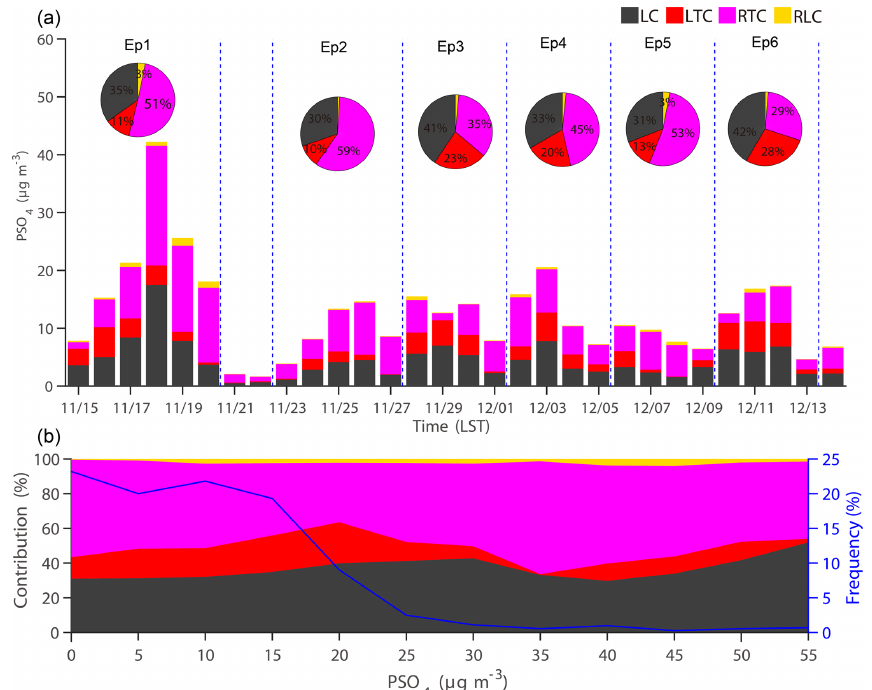
Figure 9. (a) Sources of secondary sulfate in Beijing. (b) Variation of secondary sulfate sources with the surface sulfate concentration in Beijing for the whole study period. LC refers to sulfate locally produced from SO 2 emitted in Beijing; LTC refers to sulfate chemically formed in regions outside of Beijing from SO 2 emitted in Beijing; RTC is sulfate chemically formed along the transport pathway to Beijing from SO 2 emitted in source regions outside Beijing; RLC is sulfate produced in regions outside Beijing from locally emitted SO 2 and then transported to Beijing. PSO 2 refers to particulate sulfate. Sections of the pie charts where the values are not specified represent values of less than 3%.